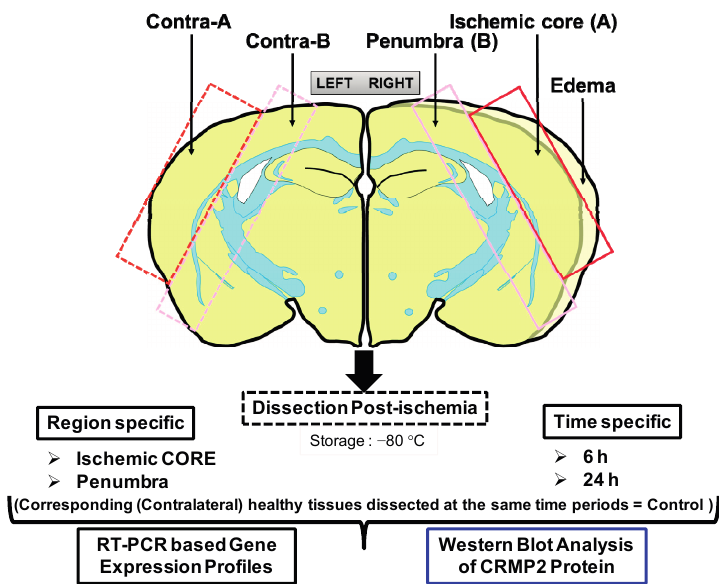
Figure 1. Experimental design and workflow using the permanent middle cerebral artery occlusion (PMCAO) model. Effect of the intracerebroventricular administered pituitary adenylate-cyclase activating polypeptide 38 (PACAP38) into ischemic mouse brain was evaluated at the molecular level in the ischemic core and penumbra of the ipsilateral ( right ) hemisphere along with the corresponding regions in the healthy contralateral hemisphere ( left ). All marked brain regions were sampled and finely powdered in liquid nitrogen, followed by investigation into molecular level changes at the level of genes (mRNA abundance) and protein expression by reverse transcription-polymerase chain reaction (RT-PCR) and Western blotting,